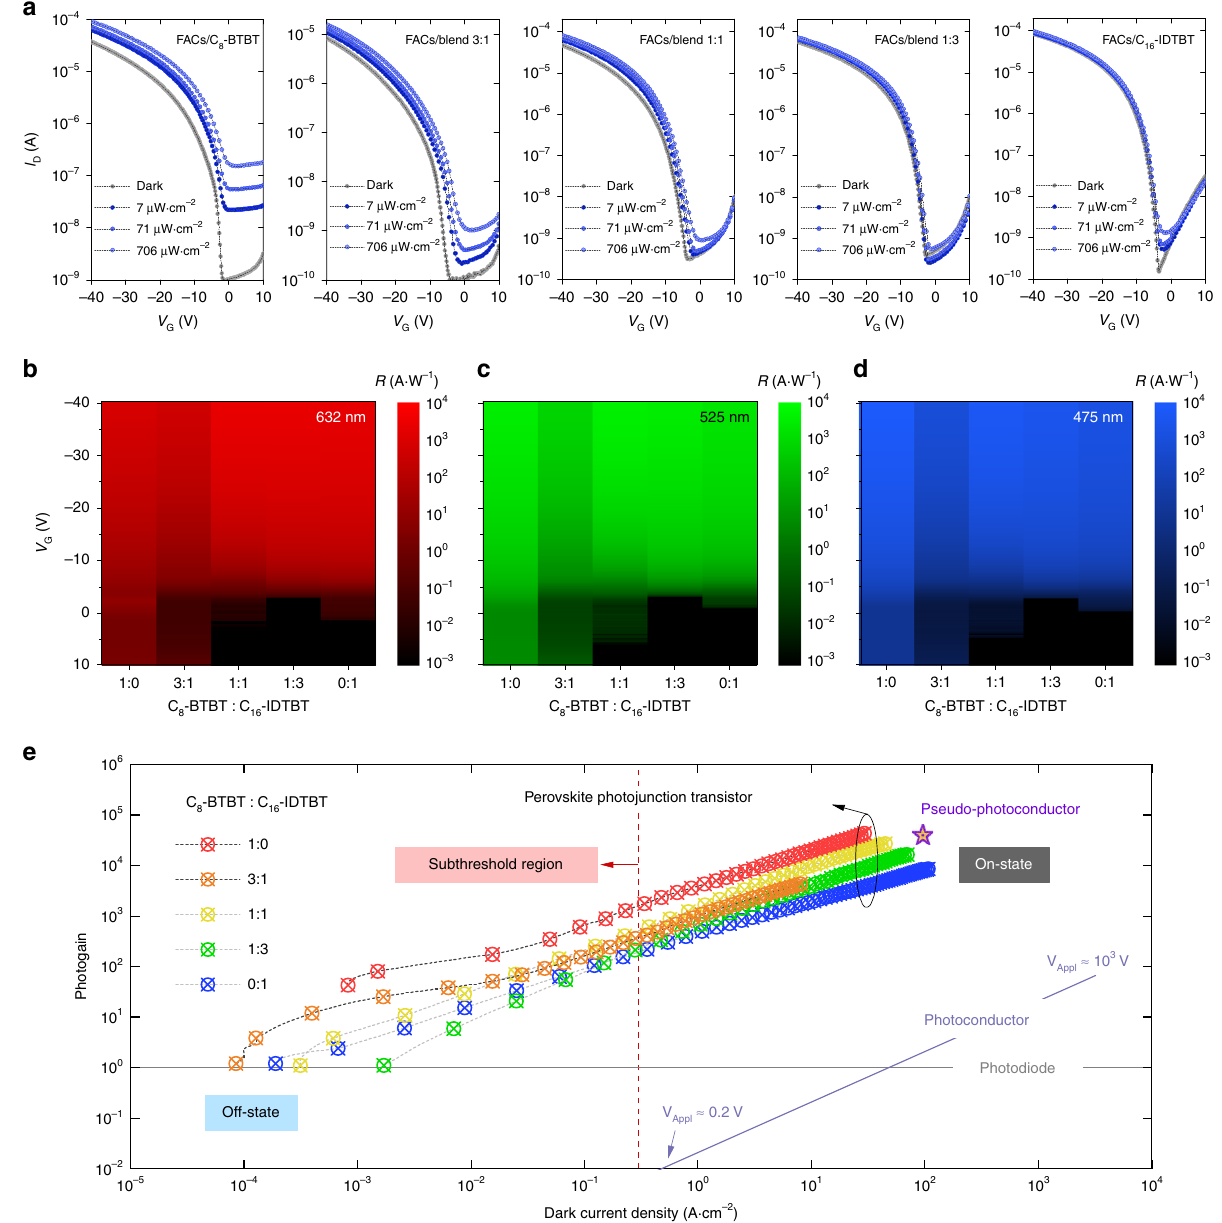
Fig. 2 On-demand photoresponsivity and photogain analysis. a Transfer I-V characteristics (V D = − 40 V) for FACs/OSC HJPTs based on pristine C 8 -BTBT, pristine C 16 -IDTBT and organic blends with different C 8 -BTBT:C 16 -IDTBT blend ratios under a 475-nm LED light source with various intensities. b – d Gate-voltage dependent photoresponsivity (R) measured at V D = -40 V from HJPTs based on C 8 -BTBT, C 16 -IDTBT and different blend ratios under different light sources: b 632 nm; c 525 nm; d 475 nm, all under ~7 µ W cm − 2 incident optical power density. e Photogain as a function of dark current density for HJPTs with different OSCs at ~ 7 µ W cm − 2 incident power from a 475-nm LED light source. For comparison, a photoconductor model is calculated based on the same channel dimension using the drift current equation 31 with applied voltages ( V appl ) ranging from 0.2 to 10 3 V. A pseudo- photoconductor modelled to achieve a high-gain level (~4 × 10 4 ) is set to operate at V appl = 40 V using the same parameters for the drift current equation, but requires a carrier lifetime of 20 ms. The theoretical limit for the photogain from a photodiode is drawn for reference